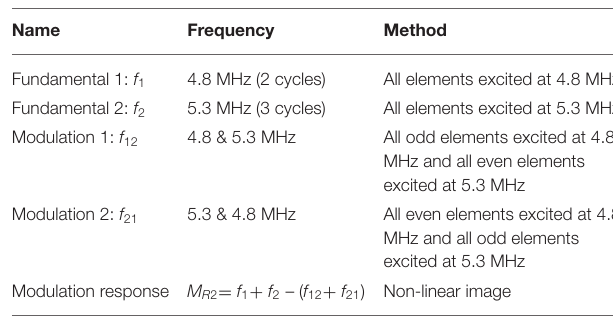
A standard broadband 128 element (2.5 MHz − 7 MHz— Diagnostic Sonar Probe and System) phased array probe (element pitch = 0.5257 mm and width = 0.5 mm) utilizing a stepped- linear (sequential) firing approach over 32 elements was used for these